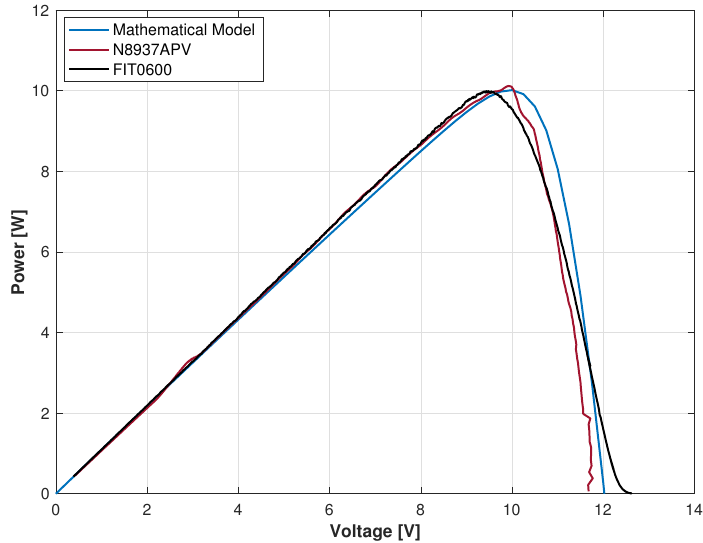
Figure 20. Power against voltage under STC profiles comparison. Furthermore, in order to sustain that the dynamics of the N8937APV and the math- ematical model are valid representations of the real power behavior of the PV array, the errors and the precision of the representations against the experimental PV arrays were es- timated through the quantified data; the N8937APV PV array simulator achieved 12.8089% average error that led to 87.1911% precision; meanwhile, the mathematical model compared to the experimental array achieved 84.7796% precision with an average error of